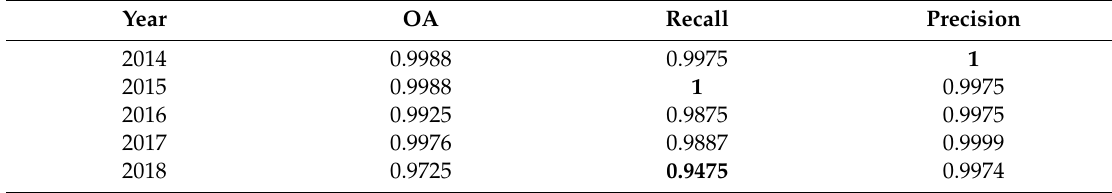
Table 3. Accuracy evaluation indices for water identification processes from 2014 to 2018.